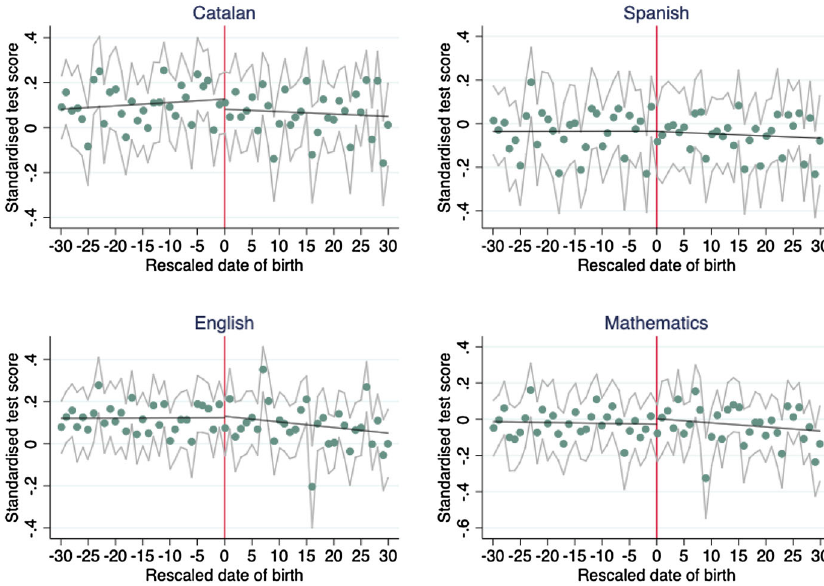
Fig. 8 Placebo RD plots by subject, 2017 tests